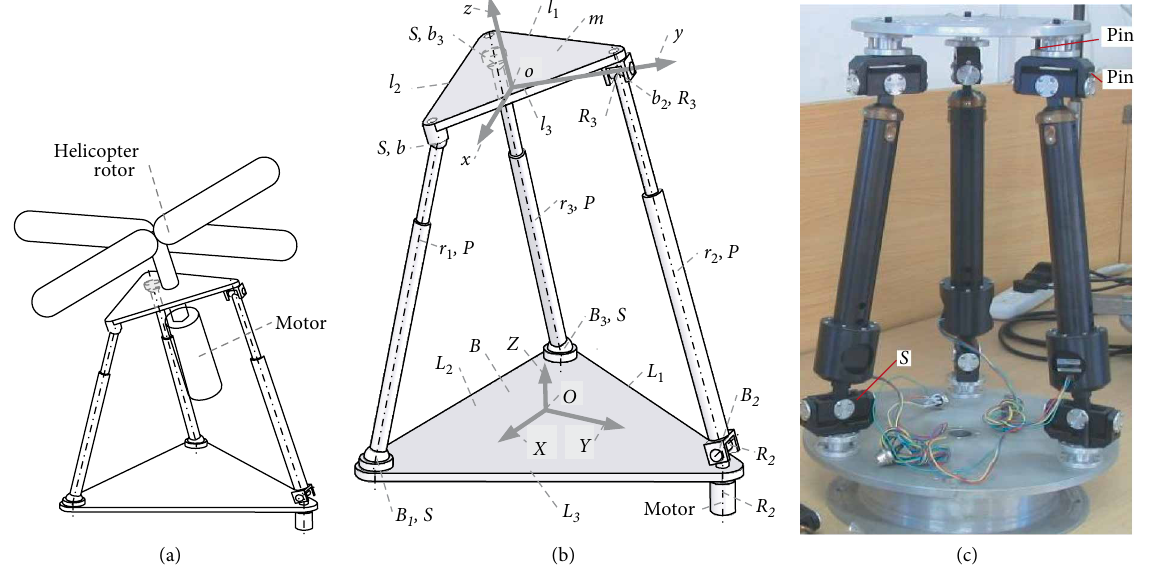
Figure 1: A 2SPS+RRPR PM for supporting helicopter rotor (a), 2SPS+RRPR type PM (b), and a prototype of reconfigurable 3SPS PM